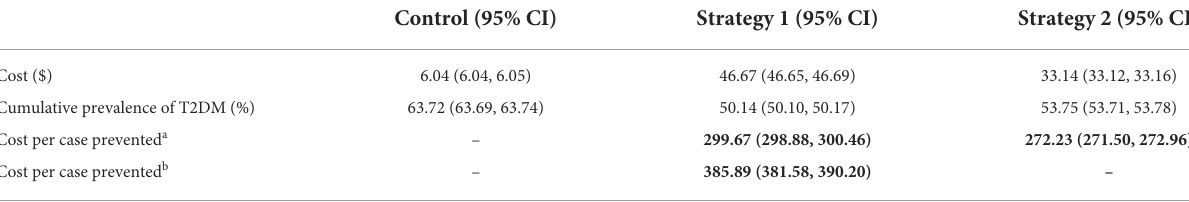
TABLE 2 Clinical and economic results for different screening strategies.